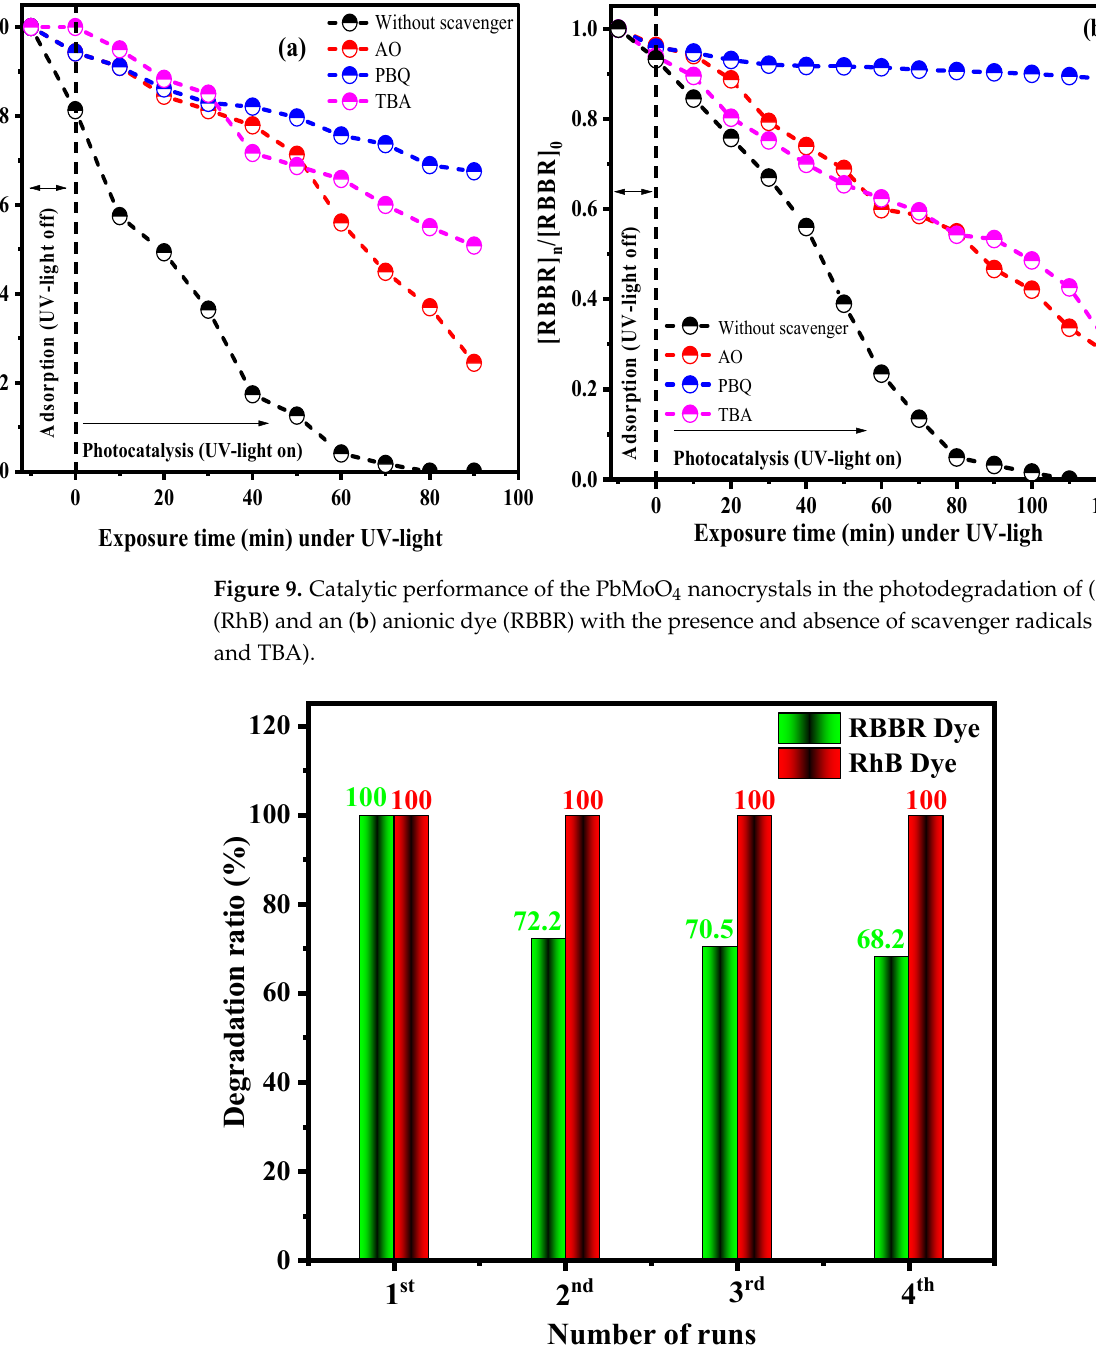
Figure 10. Reusability of PbMoO 4 -10 in the photodegradation of RhB (cationic) RBBR (anionic) dye. Initial conditions = 50 mg of PbMoO 4 -10, volume of dye = 50 mL, time = 90 min (RhB) and 120 min (RBBR).